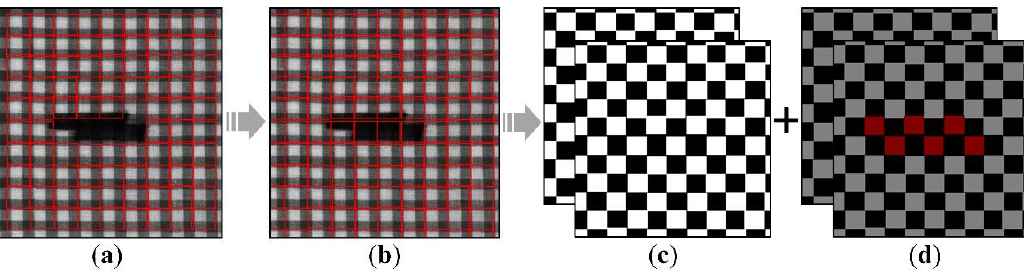
Figure 2. ( a ) The grid layout extracted by the repeated pattern detector and drawn on the original image. ( b ) The edges and defects are filled with grids. ( c , d ) The input labels and the one-hot encoded target labels of the semantic segmentation network.